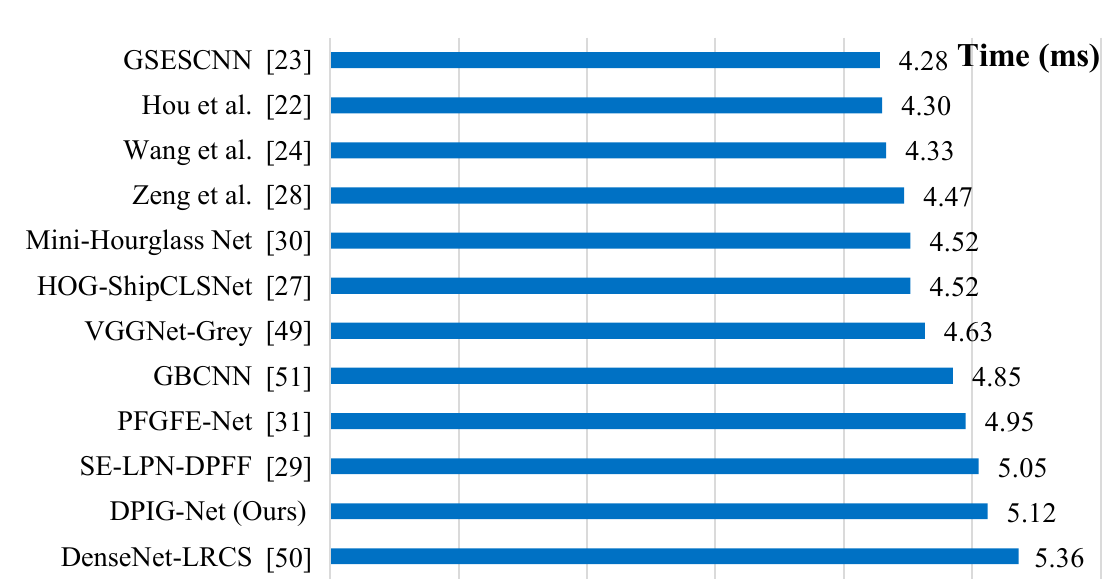
Table 5. Confusion Matrix of the Three-Category Task.